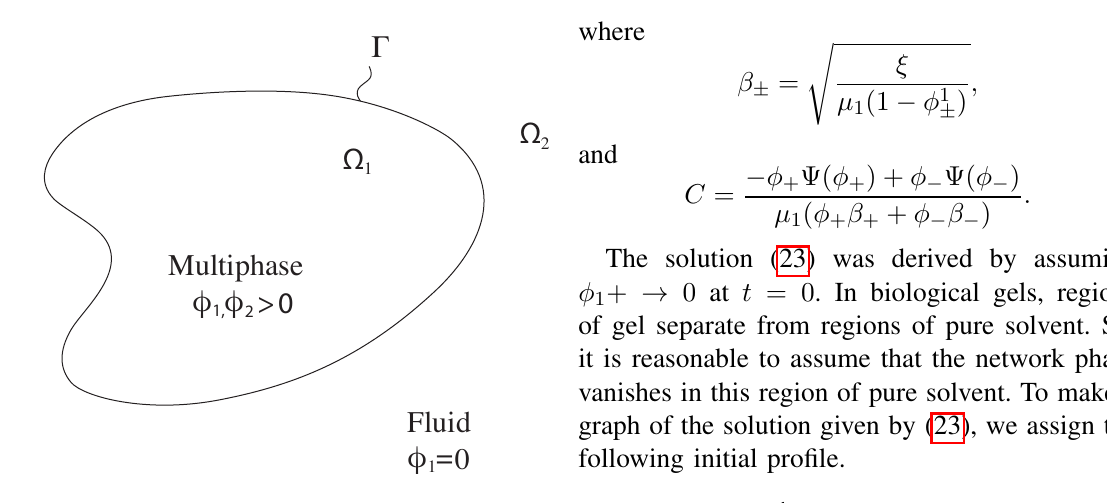
Fig. 1. This shows the region Ω 2 of pure solvent ( φ 1 = 0 ) separated at the boundary Γ from the region Ω 1 containing the mixture of both